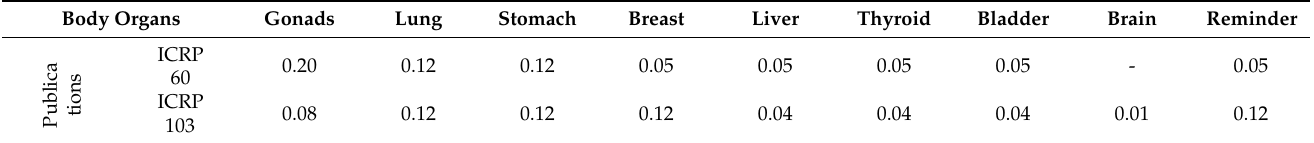
Table 1. ICRP 60 and 103 tissue weighting